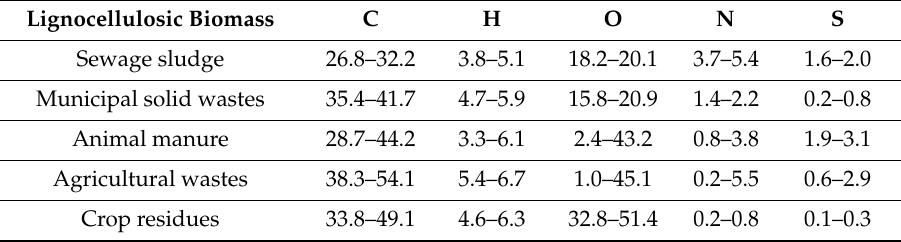
Table 2. Average elemental analysis of some organic wastes classified as LB (expressed as percentage in dry